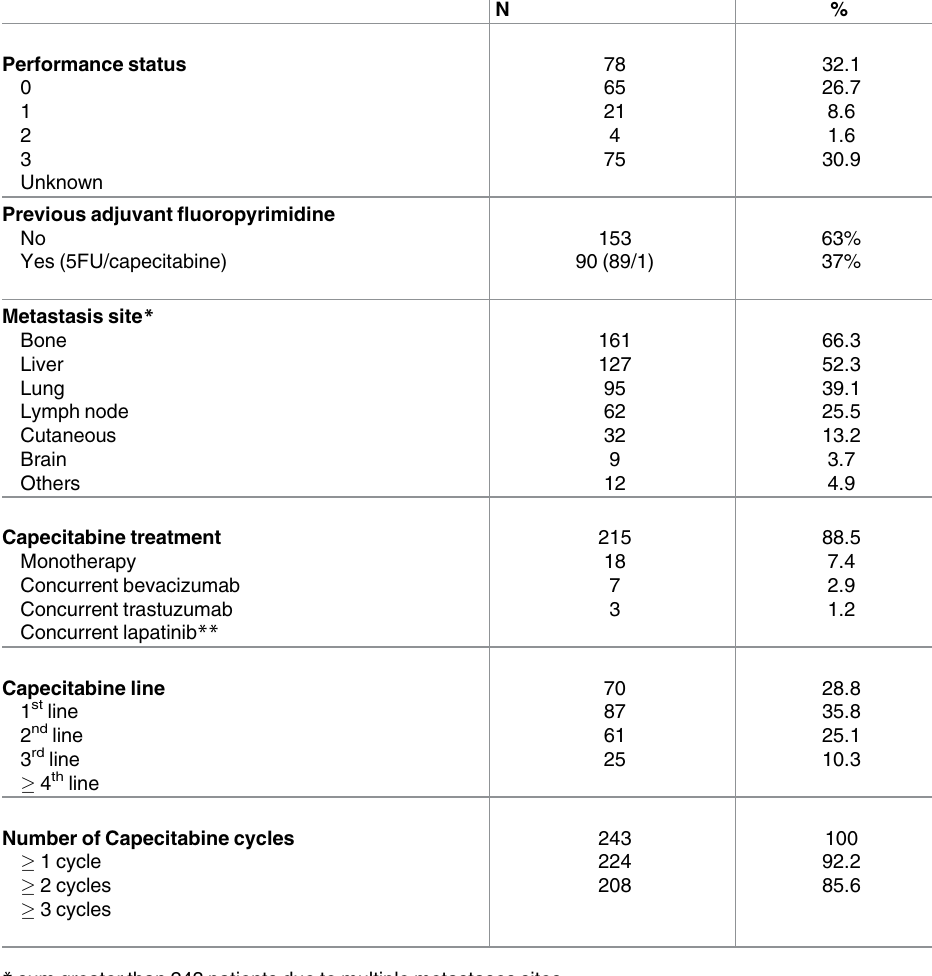
Table 1. Patient and treatment characteristics (N =